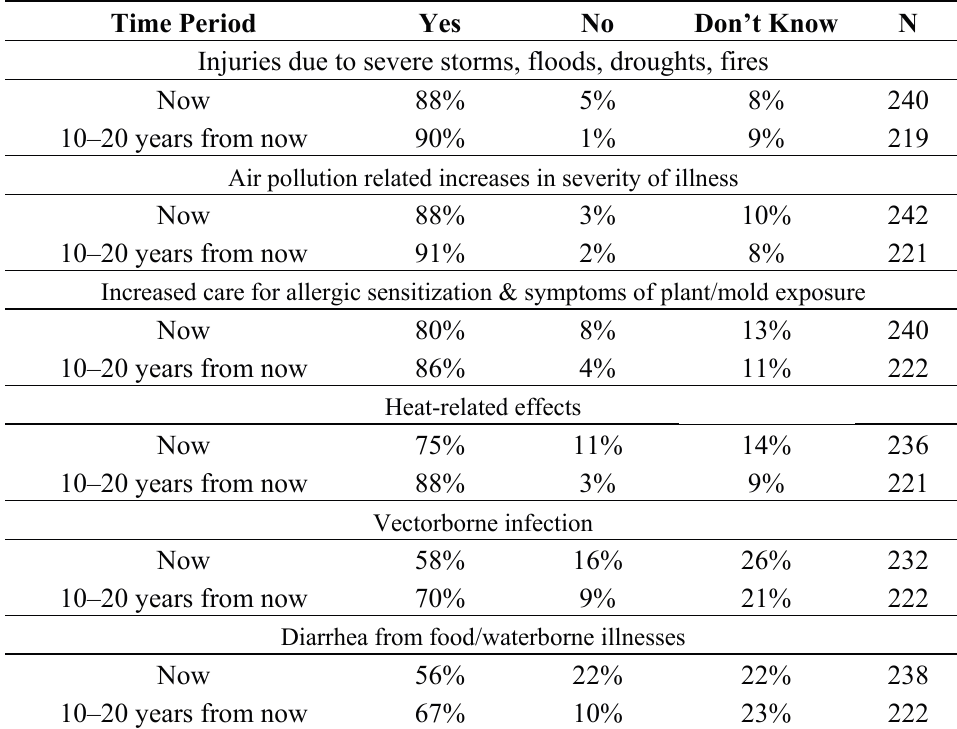
Table 1. Responses to the question: In which of the following ways, if any, do you think your patients are currently being affected by climate change, or might be affected in